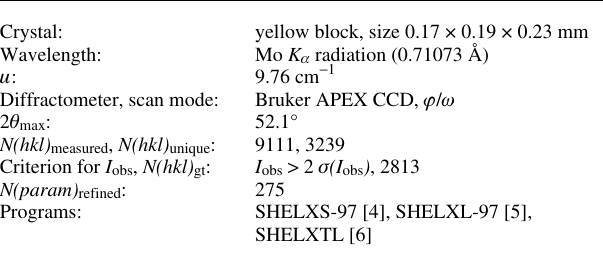
Table 1. Data collection and handling.